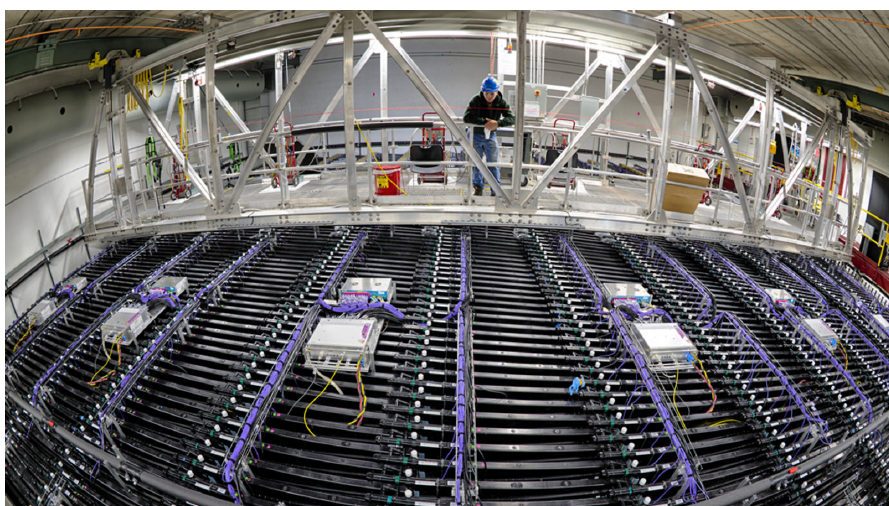
Figure 5. The NO ν Adetector at Ash